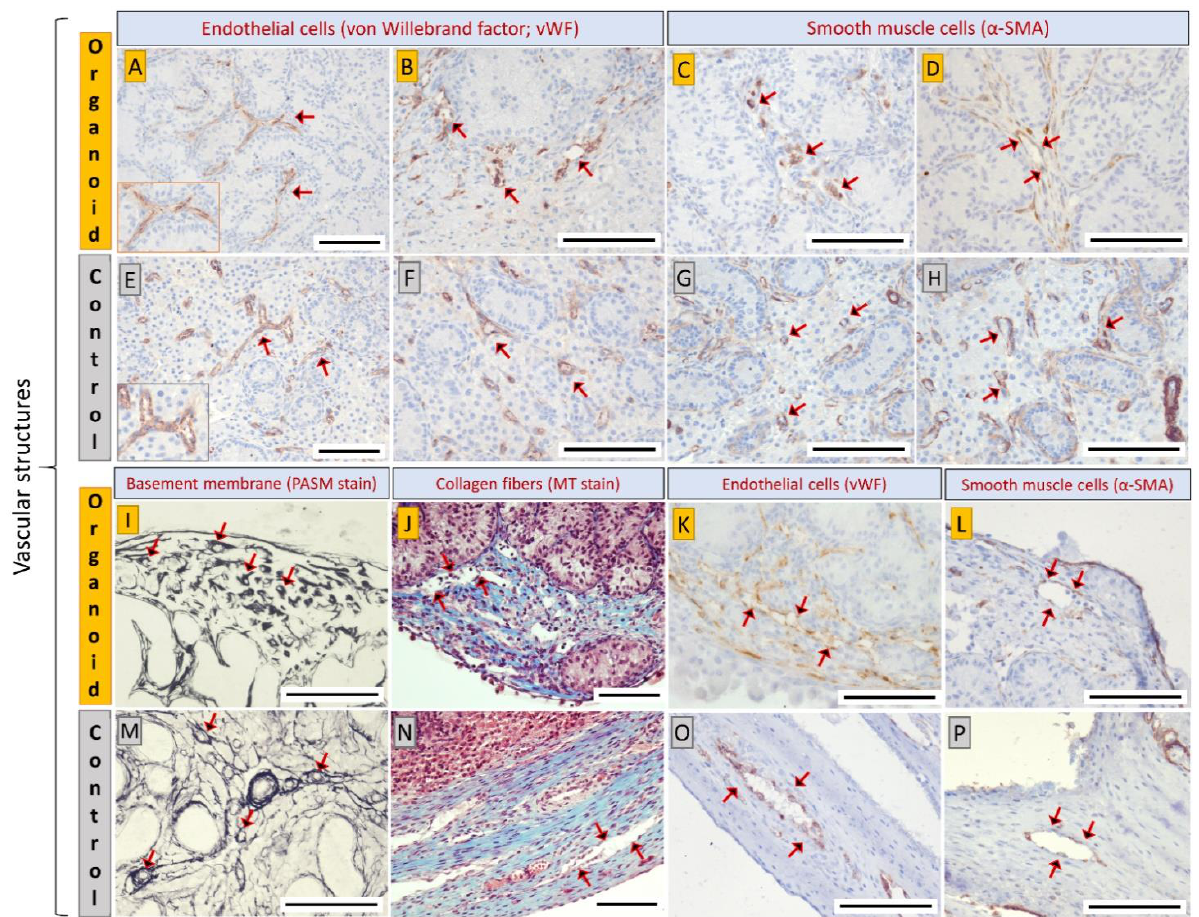
structed by collagen fibers (blue) were detected in the organoids using Masson’s trichrome (MT). Also, Leydig cells ( B ( iv )) were detected by CYP17A and were observed in the inter-tubular interstitium. ( B ( v – viii )) Imaging of intact testis tissue (controls) with the corresponding cell types and structures. Scale bars: 100 µm ( A ( i – iii ), A ( v – vii ), B ( i – viii ); 5 µm ( A ( iv , viii )).